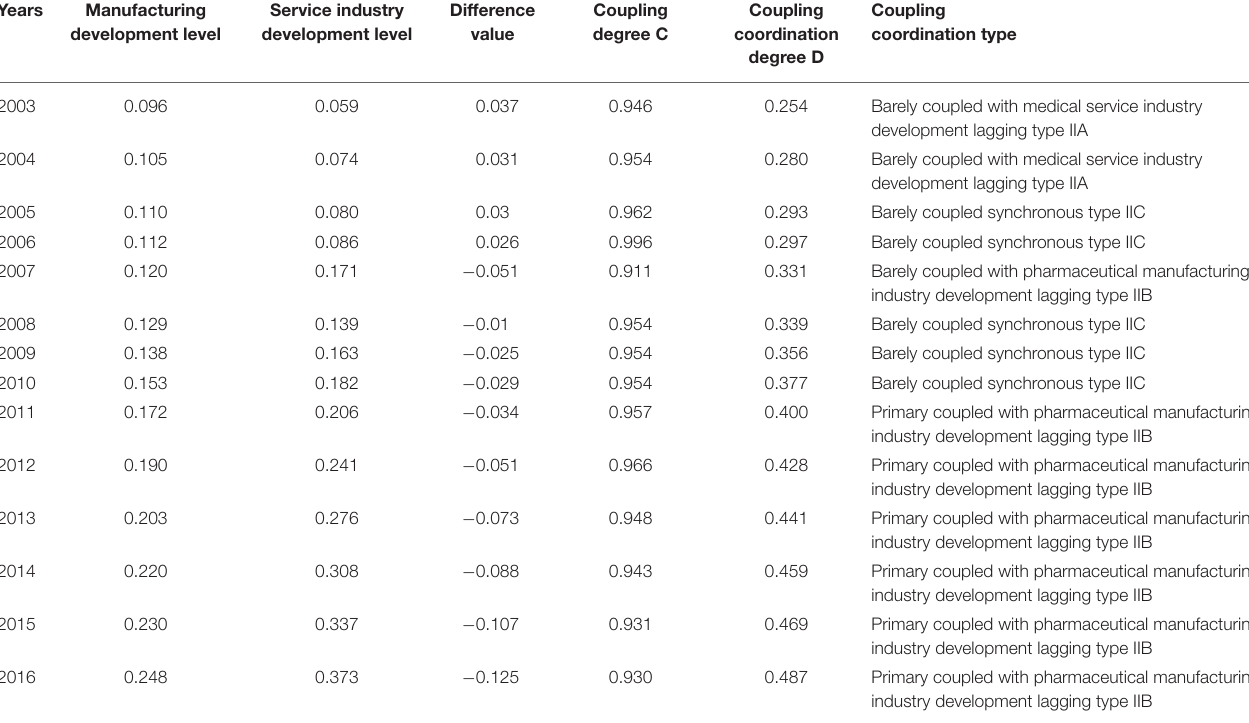
TABLE 3 | Annual results for the coupling and coordination degree between the pharmaceutical manufacturing industry and the medical service industry.